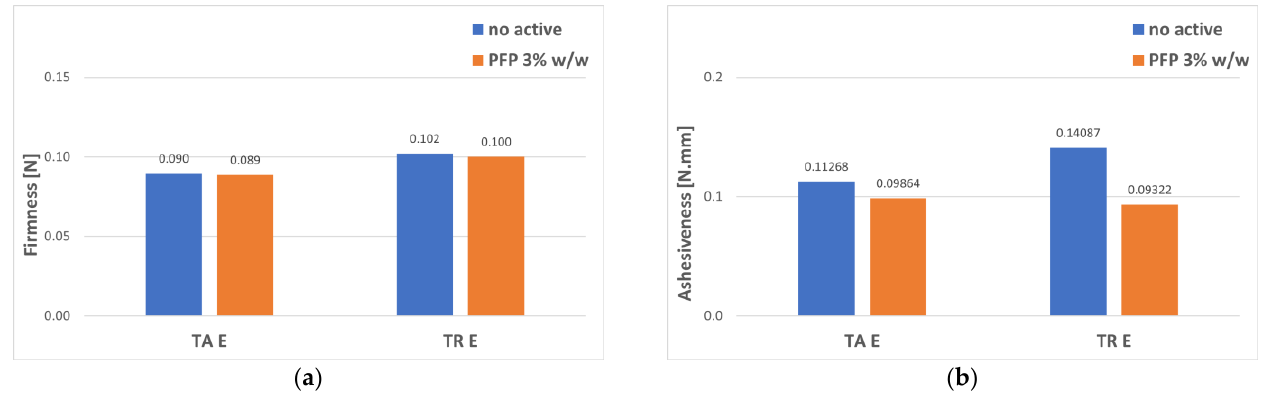
Figure 12. Texture parameters measured before and after adding 3% w / w of PFP for the gel – creams TA E prepared with T at 0.2% w / w , A at 0.2% w / w , and E at 0.3% w / w and TR E prepared with T at 0.2% w / w , R at 0.2% w / w and E at 0.3% w / w : ( a ) firmness and ( b ) adhesiveness.